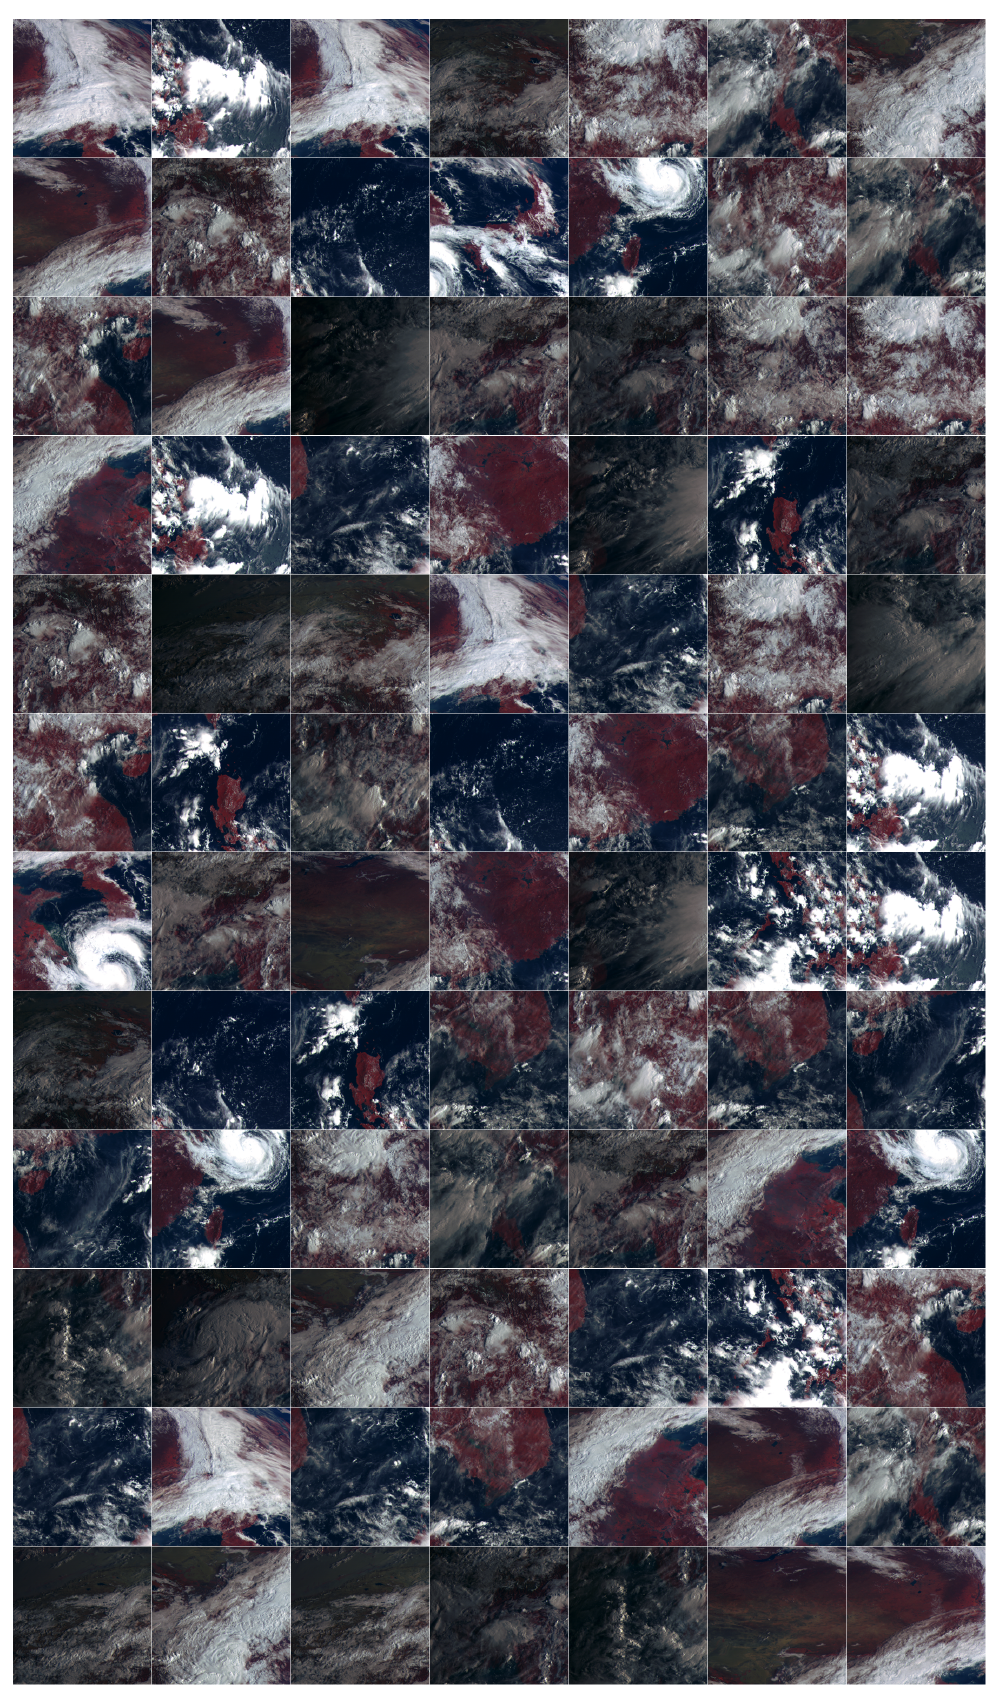
Figure 2. Image patches from the FY4ASRcolor